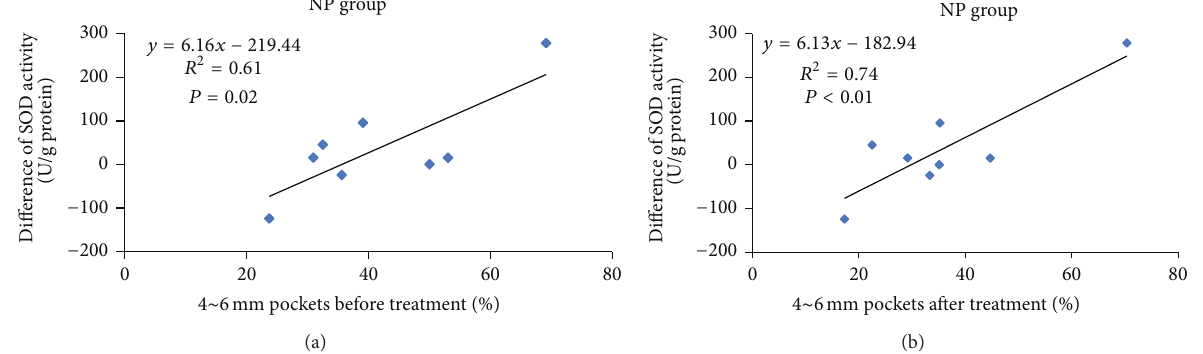
Figure 2: Scatterplots of superoxide dismutase (SOD) activity difference and 4 ∼ 6 mm pocket percentages in the nonprogress (NP) group. (a) Percentages of 4 ∼ 6mm pockets before treatment. (b) Percentages of 4 ∼ 6 mm pockets after